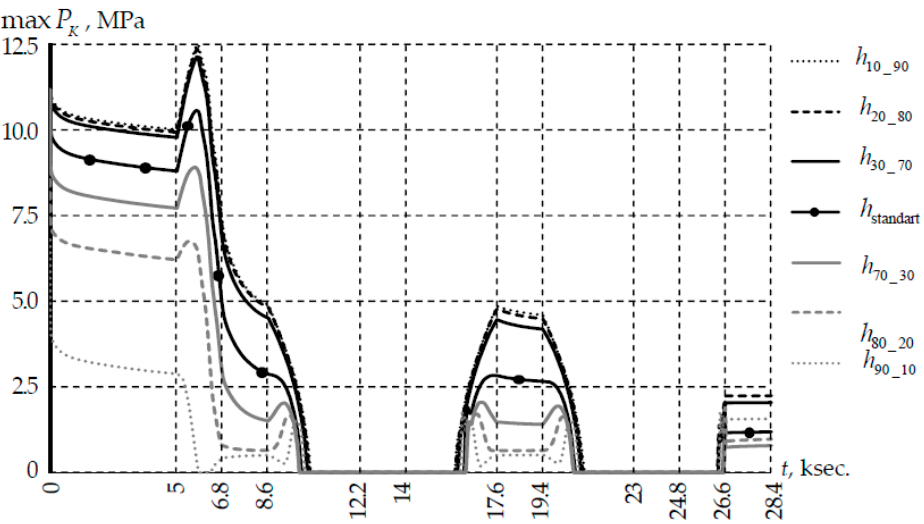
Figure 8. Evolution of contact pressure under thermal cycle conditions.